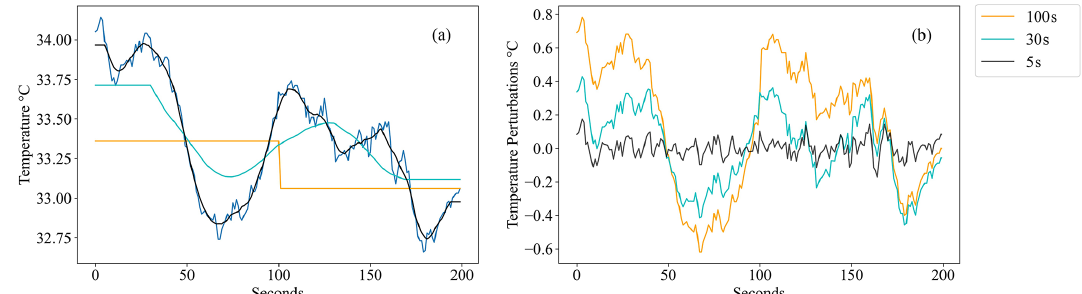
Figure 2. Sample pixel: (a) temperature and (b) temperature perturbations – example showing impact of different running filter sizes to calculate the perturbations. (a) Temperature measurement from a sample pixel of the IR camera. Dark blue is the original temperature, and the smoothed lines are the running mean used for the perturbation calculation (see legend for the length). The corresponding perturbation scales are shown in panel (b) . The mean of 100s only allows large perturbation influences to be shown while the smaller perturbation window of 5s accounts for small-scale